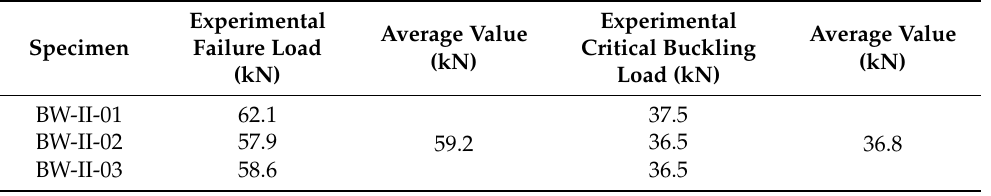
Table 5. Experimental results of the failure load and critical buckling load—the PWF composite beams of BW-II.